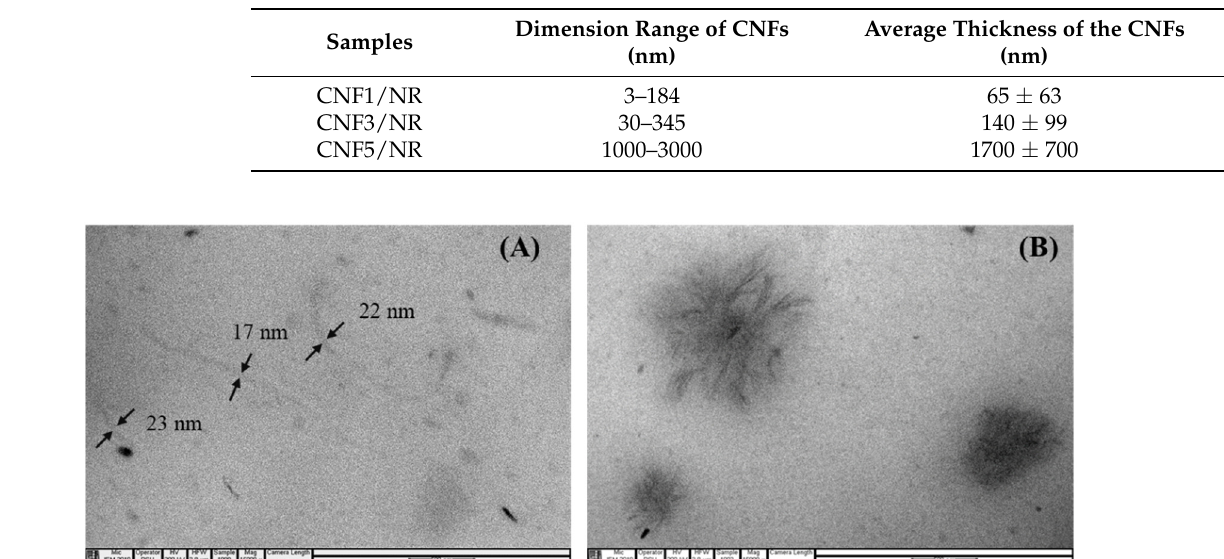
Figure 2. TEM images of ( A ) CNF1/NR, ( B ) CNF3/NR, and ( C ) CNF5/NR at low magnification (X5000). Table 2. Dimensions of the dispersed CNFs in the CNF/NR nanocomposites. Table 2. Dimensions of the dispersed CNFs in the CNF/NR nanocomposites.